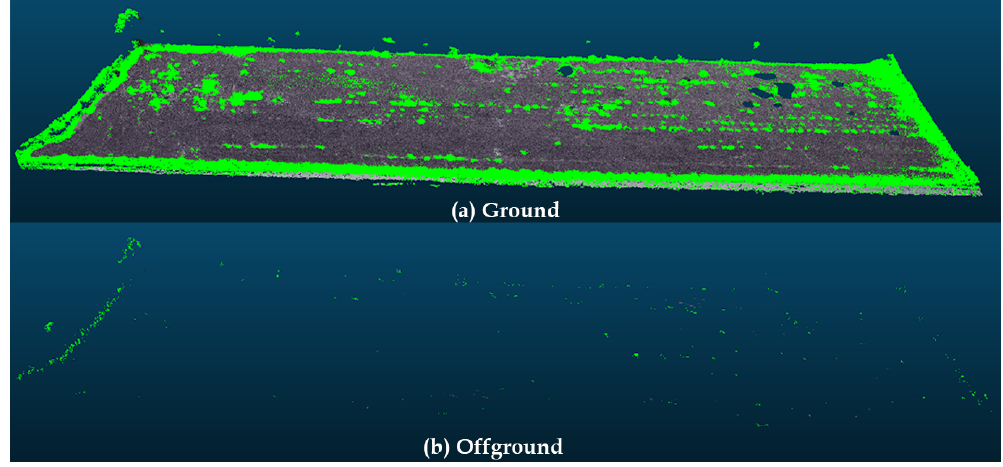
Figure 16. Classified vegetation show marked in green.